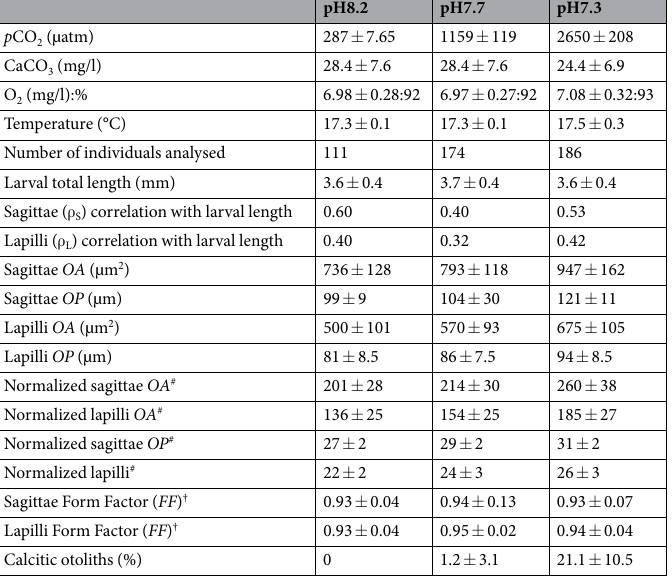
Table 1. Gilthead sea bream rearing conditions and otolith morphometry. All values are expressed as mean ± standard deviation. Water parameters were averaged for all replicate tanks and days of treatment, therefore represent global treatment values. ρ S/L values indicate Pearson correlation coefficient. # Normalized values = OA or OP /Larval total length. † Form Factor (FF) = 4 π OA x OP − 2 , where OA is the sagittal area and OP is the perimeter. Calcitic = percentage of larvae with at least one of the two otolith pairs formed by